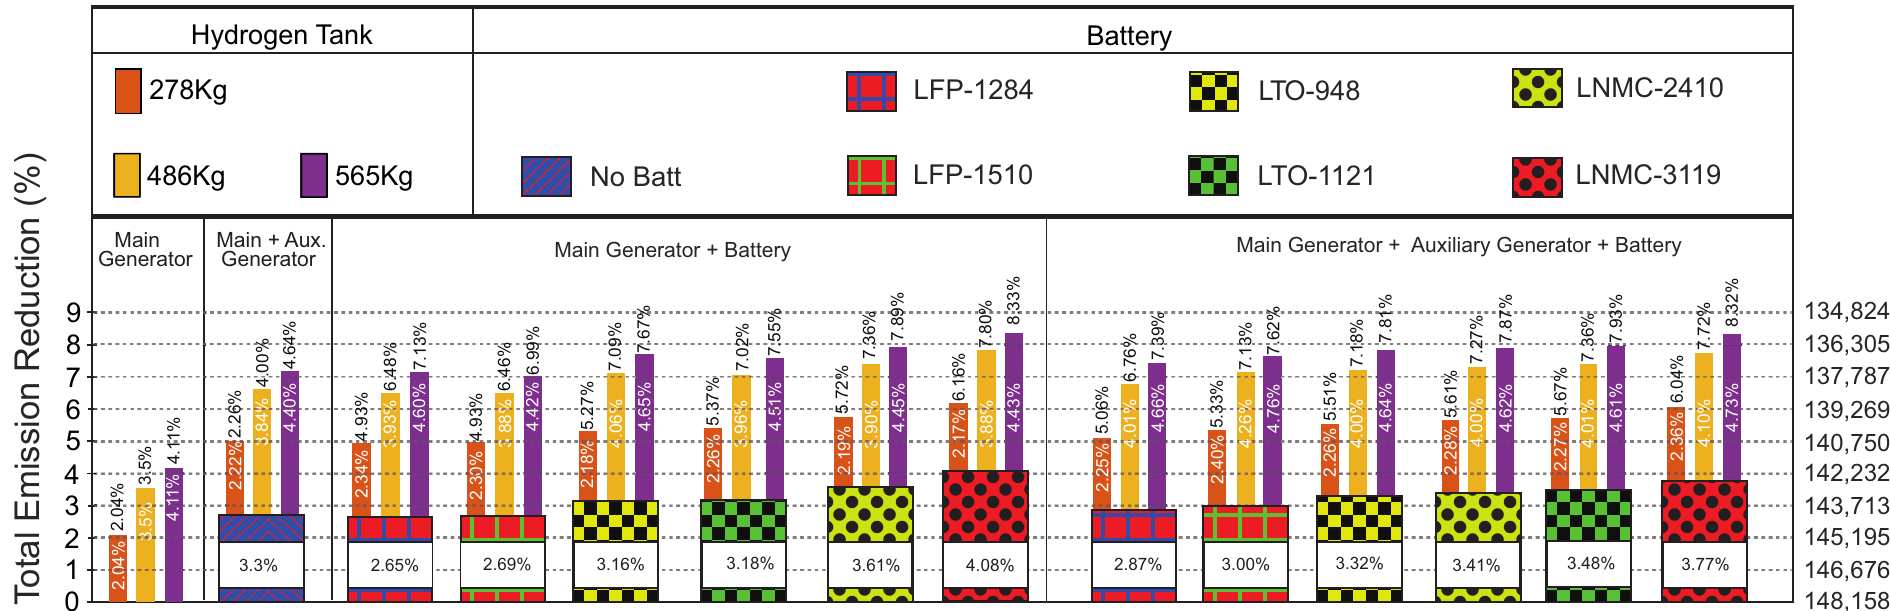
Figure 12. Total emission reduction results obtained from the configurations operating at 10% higher